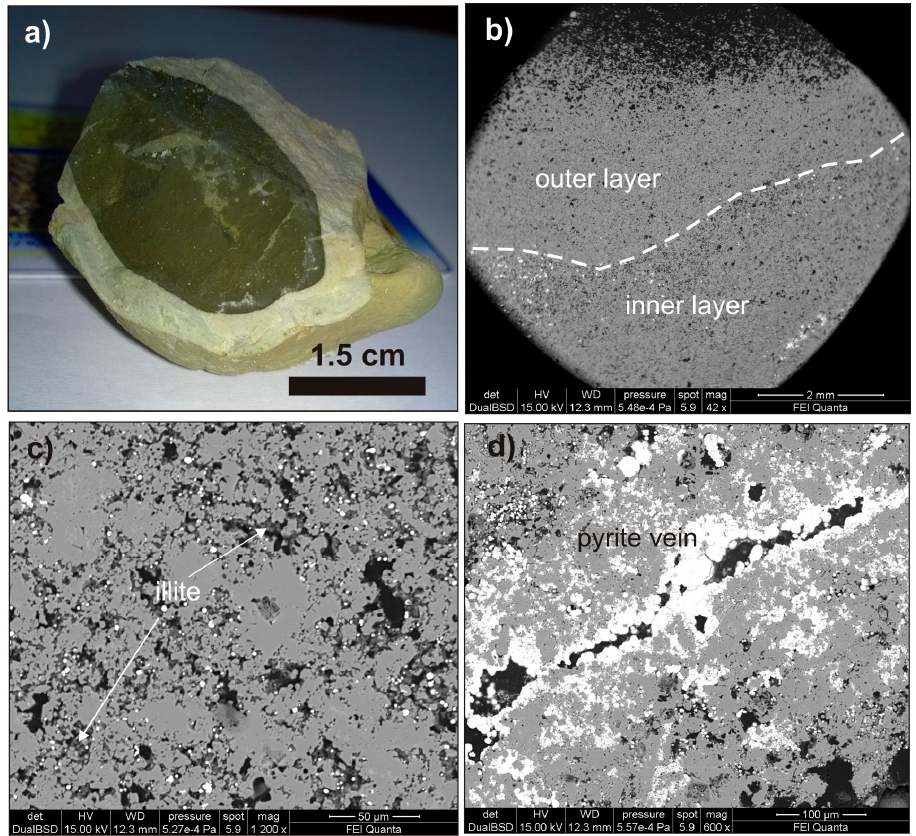
Figure 7. Hand specimen ( a ) and BSE images ( b – d ) of ST9BNR2B quartz-pyrite altered sample. Quartz-pyrite association with illitic patches ( c ) and pyrite veins ( d ).